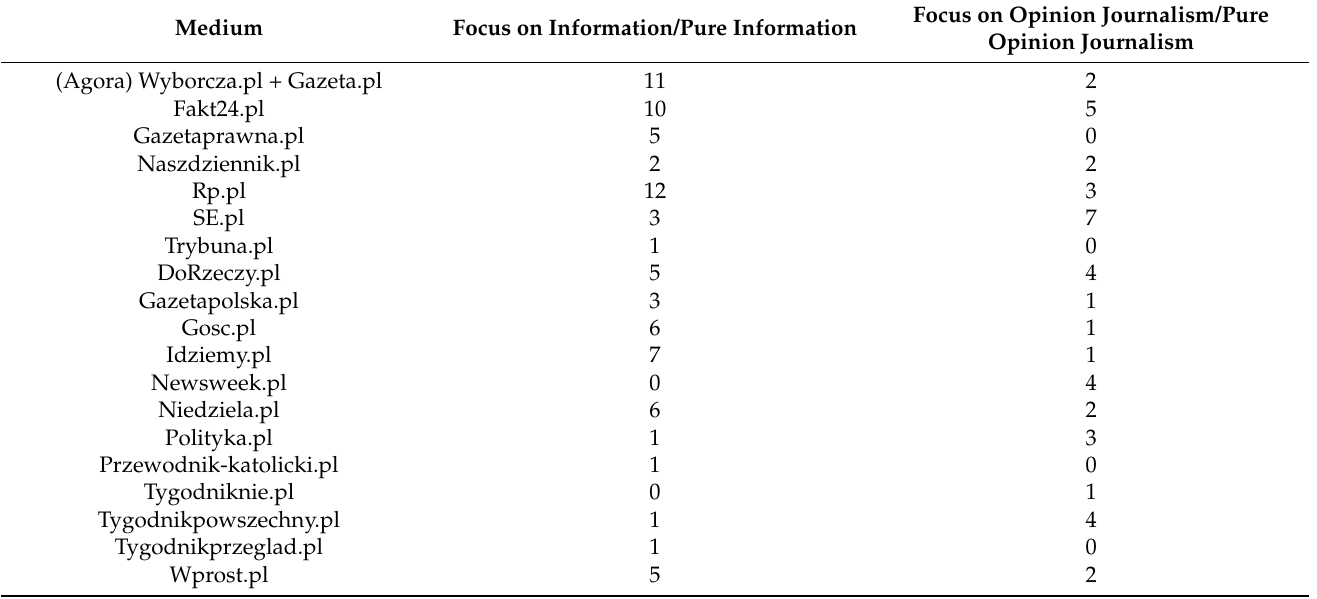
Table 3. Contextuality—informativeness vs. opinion